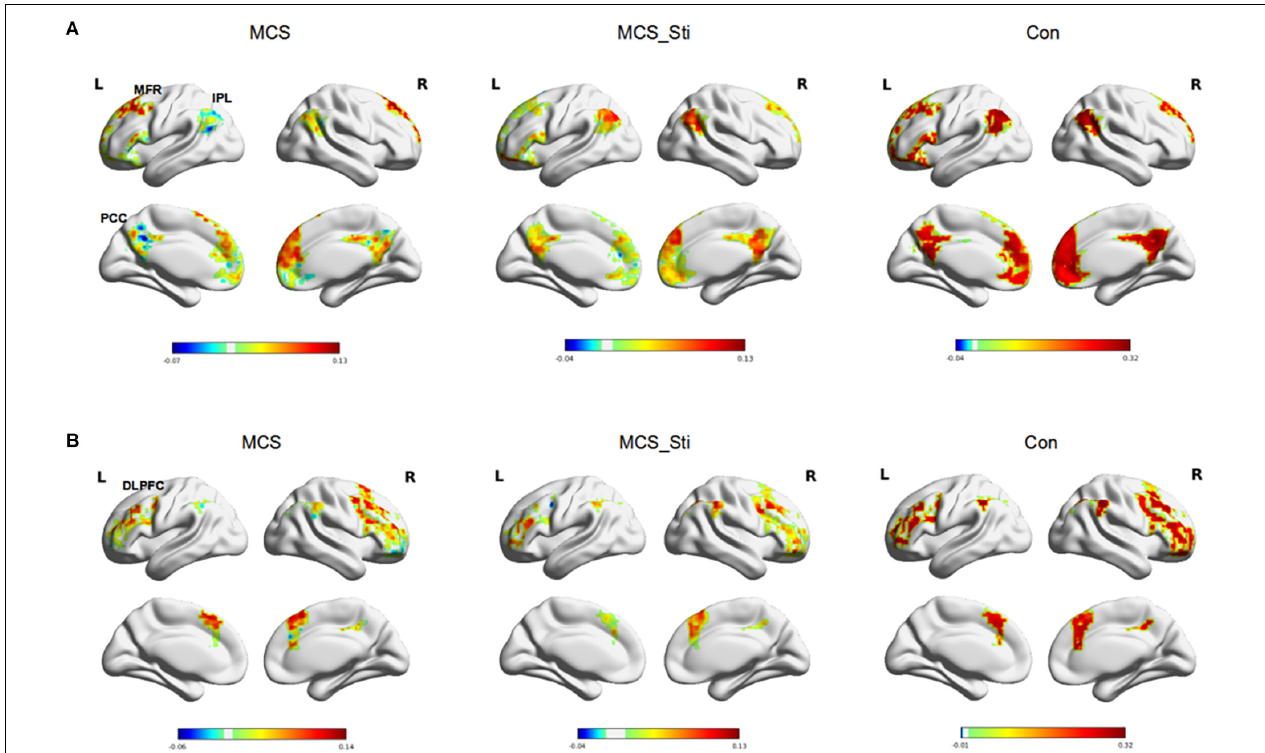
FIGURE 2 | GBC analysis of fMRI in controls (Con) and patient 1 (MCS) before and after stimulation treatment. (A) DMN network. First panel: before treatment, patient showed decreased activity in regions, including the IPL, MFR, and PCC. Second panel: after treatment, patient 1 showed an increase in IPL and PCC activity. Third panel: healthy controls. (B) ECN network. First panel: before treatment, patient 1 showed decreased activity in the DLPFC. Second panel: after treatment, patient 1 showed a decrease in DLPFC activity. Third panel: healthy controls. GBC, global brain connectivity; fMRI, functional magnetic resonance imaging; DMN, default mode network; ECN, extrinsic control network; Con, controls; MCS, minimally conscious state; MCS_Sti, minimally conscious state after treatment; MFR, mesiofrontal region; IPL, inferior parietal lobe; PCC, posterior cingulate cortex; DLPFC, dorsolateral prefrontal cortex.